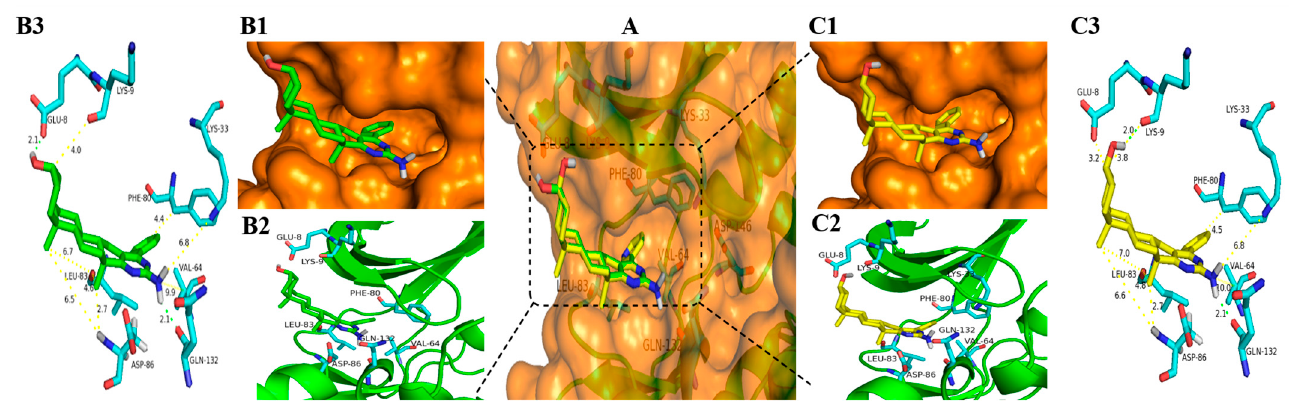
Figure 6. Docking modes of 3a and 6a with CDK1 (PDB code: 6GU6). ( A ) Overview of the binding site of 3a (green stick) and 6a (yellow stick) with CDK1 (orange transparent surface structure fused with a sticks structure of white hydrogen atoms, cyan carbon atoms, blue nitrogen atoms, and red oxygen atoms); ( B1 ) Position of 3a in the orange surface structure of CDK1; ( B2 ) Position of 3a in cartoon structure of CDK1; ( B3 ) Binding model for 3a bond to CDK1 (Hydrogen bonds are drawn as green dashed lines with distances labelled in Å while the yellow dashed lines just display the distance between the atoms); ( C1 ) Position of 6a in the orange surface structure of CDK1; ( C2 ) Position of 6a in cartoon structure of CDK1; ( C3 ) Binding model for 6a bond to CDK1 (Hydrogen bonds are drawn as green dashed lines with distances labelled in Å while the yellow dashed lines just display the distance between the atoms). Figures were drawn with Pymol (Schrödinger).